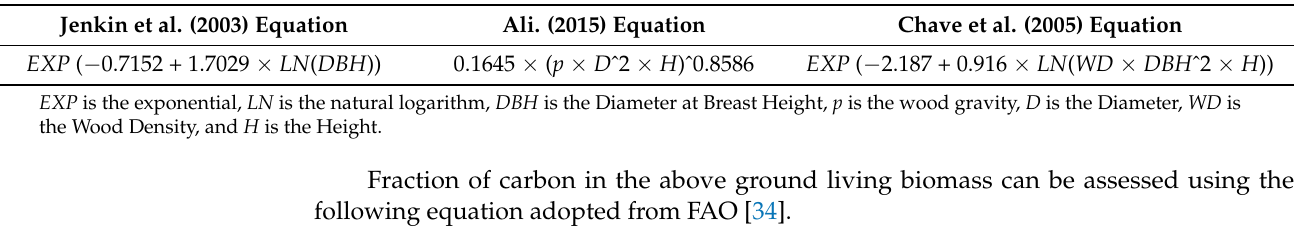
Table 2. Allometric equation used in the